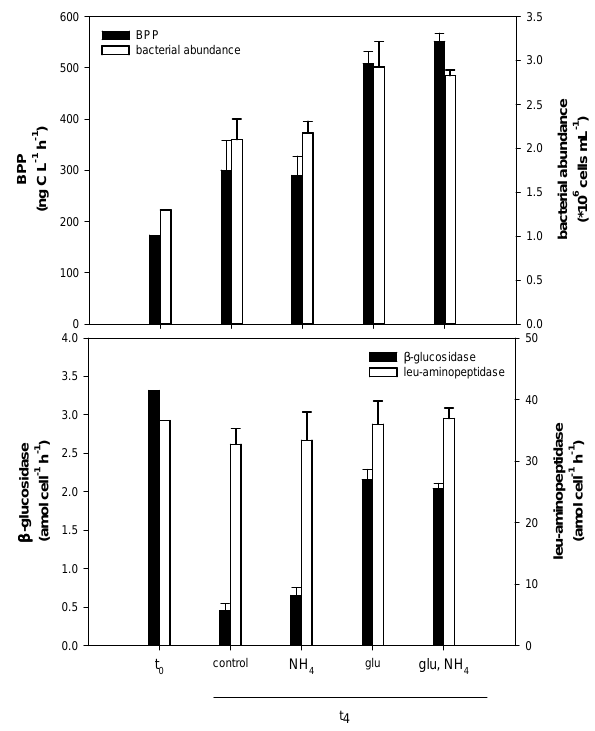
Fig. 1. Bacterial growth characteristics (upper panel; BPP: bacte- rial protein production) and extracellular enzyme activities (lower panel) in samples of the Kongsfjorden with and without amend- ments of ammonium (NH 4 ) and glucose (glu) (t0: initial sampling, t4: sampling after 4 days of incubation).